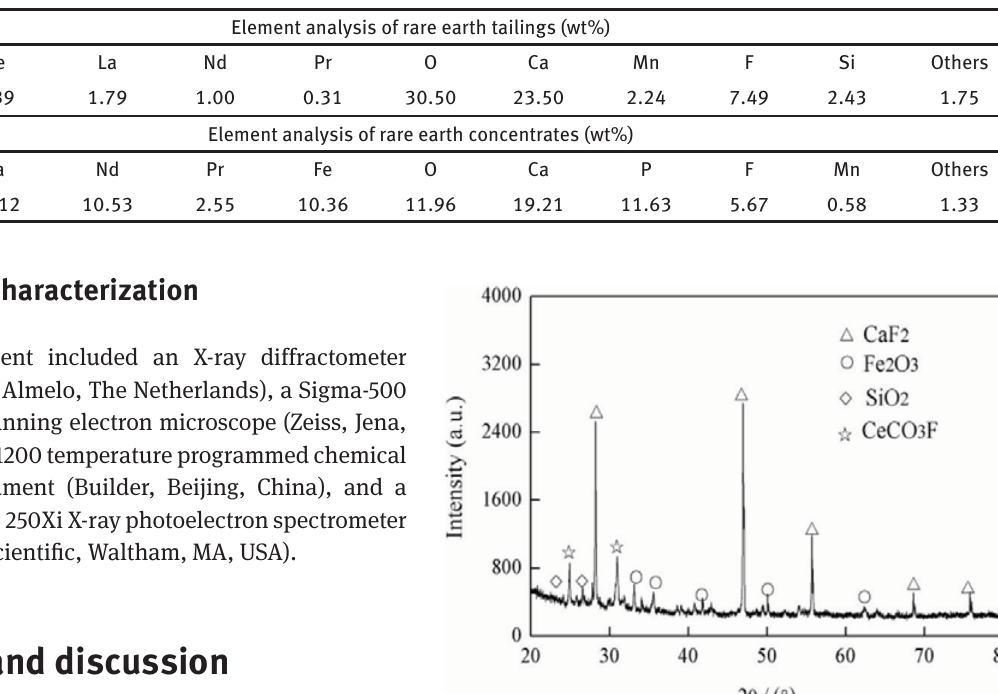
Table 1: Element analysis (wt%).